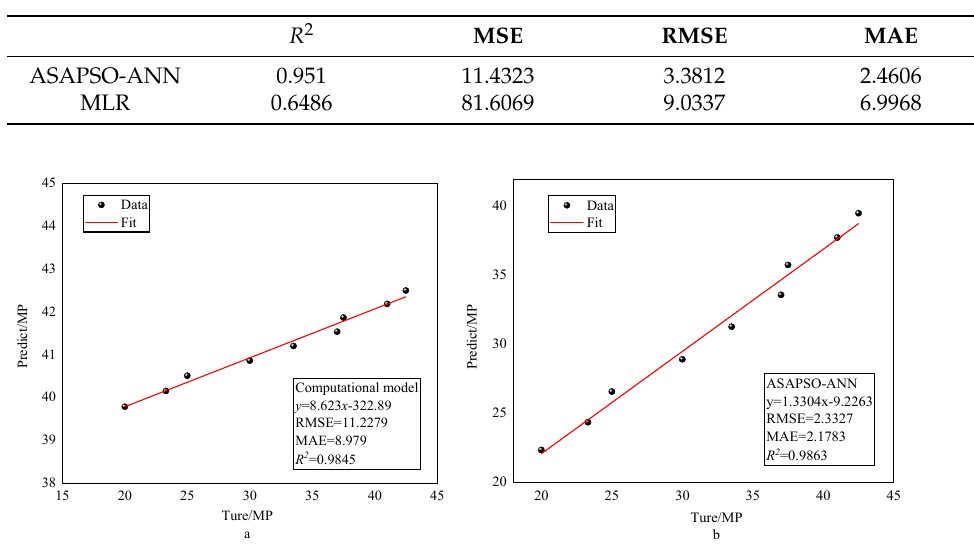
Figure 11. Results of regression analysis of two models: ( a ) for MRL and ( b ) for ASAPSO-ANN. Table 5. Metrics for MLR and ASAPSO-ANN models. Table 6. Metrics for empirical formula and ASAPSO-ANN models.